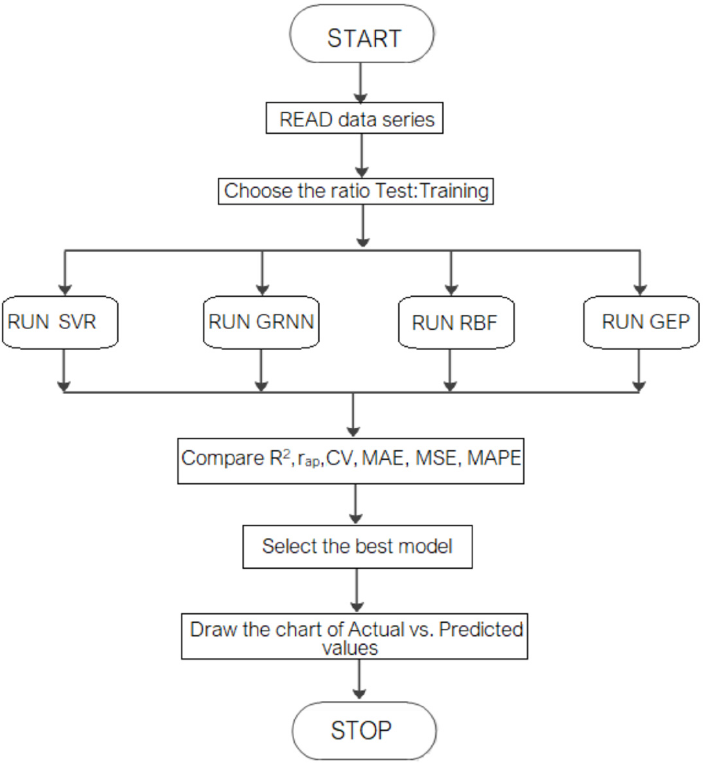
Figure 5. The flowchart of the modeling and estimation process.